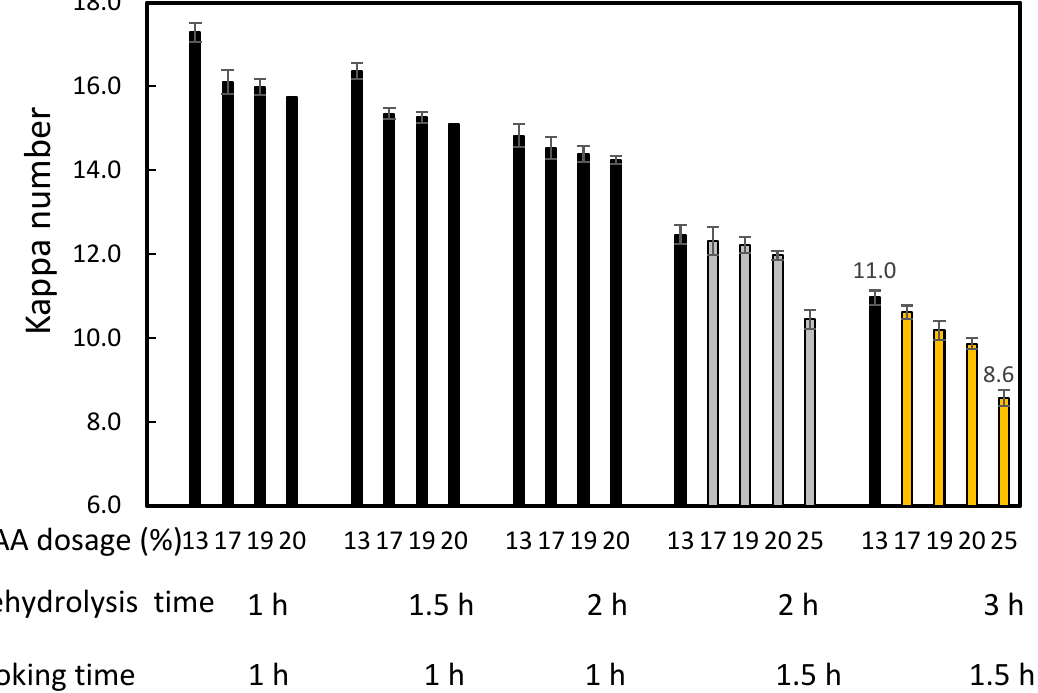
Figure 4. Effect of prehydrolysis time on the kappa number of Nypa fruticans frond soda-SAQ pulp. The values presented are averages ± standard deviations.